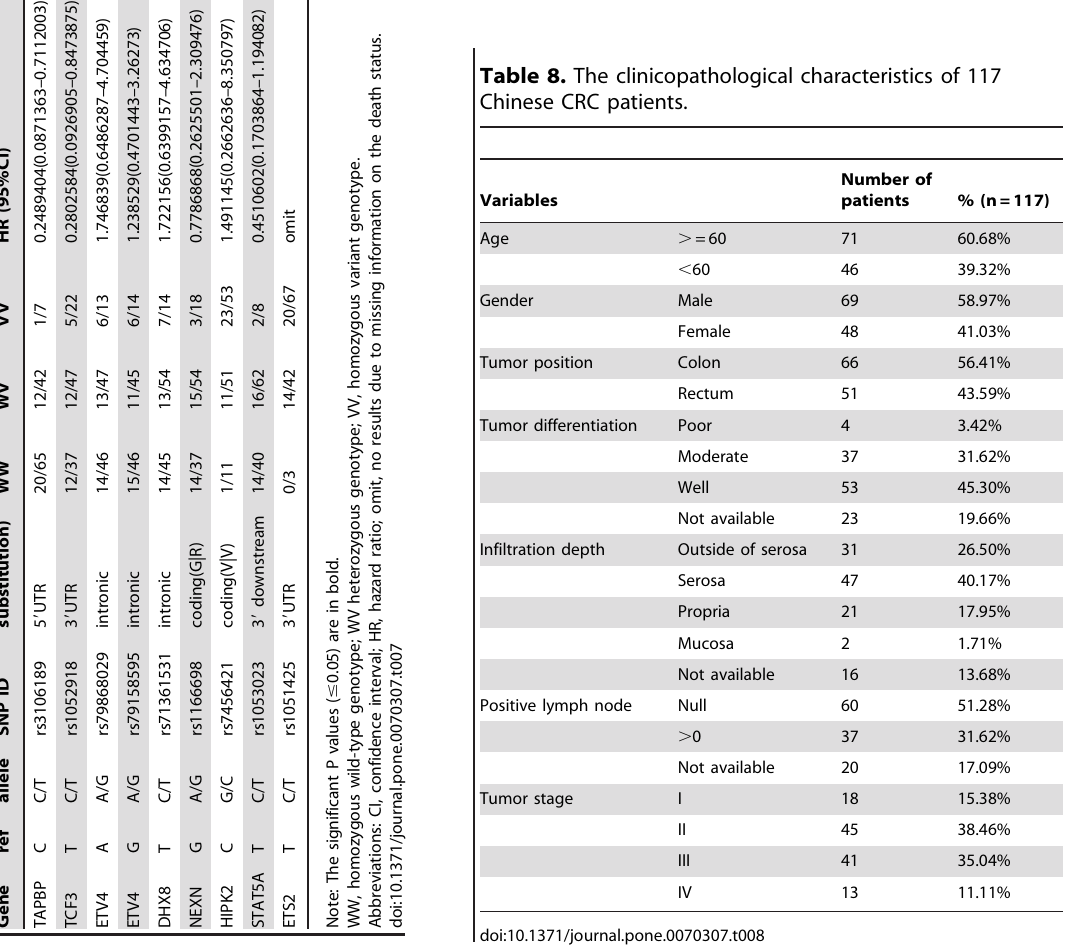
CRC patients (Figure 2) using the dominant model with hazard ratios of 0.25 (P= 0.009) and 0.28 (P= 0.024), respectively. The SNP rs3106189 was also significantly associated with CRC patient survival with the additive model (hazard ratio= 0.33, P =0.021; Table 7). The SNP rs3106189 localized to the 5 9 UTR of TAPBP, and the SNP rs1052918 localized to the 3 9 UTR of the TCF3. For the SNP rs3106189, the numbers of patients with heterozygous and homozygous variants were 42 and 7 respectively. For the SNP rs1052918, the numbers of patients with heterozygous and homozygous variants were 47 and 22 respectively. Patients bearing one of the two variants seem to have higher probabilities to survive longer.